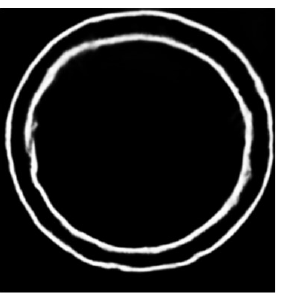
Figure 7. Diagram of the unrealized connected domains.